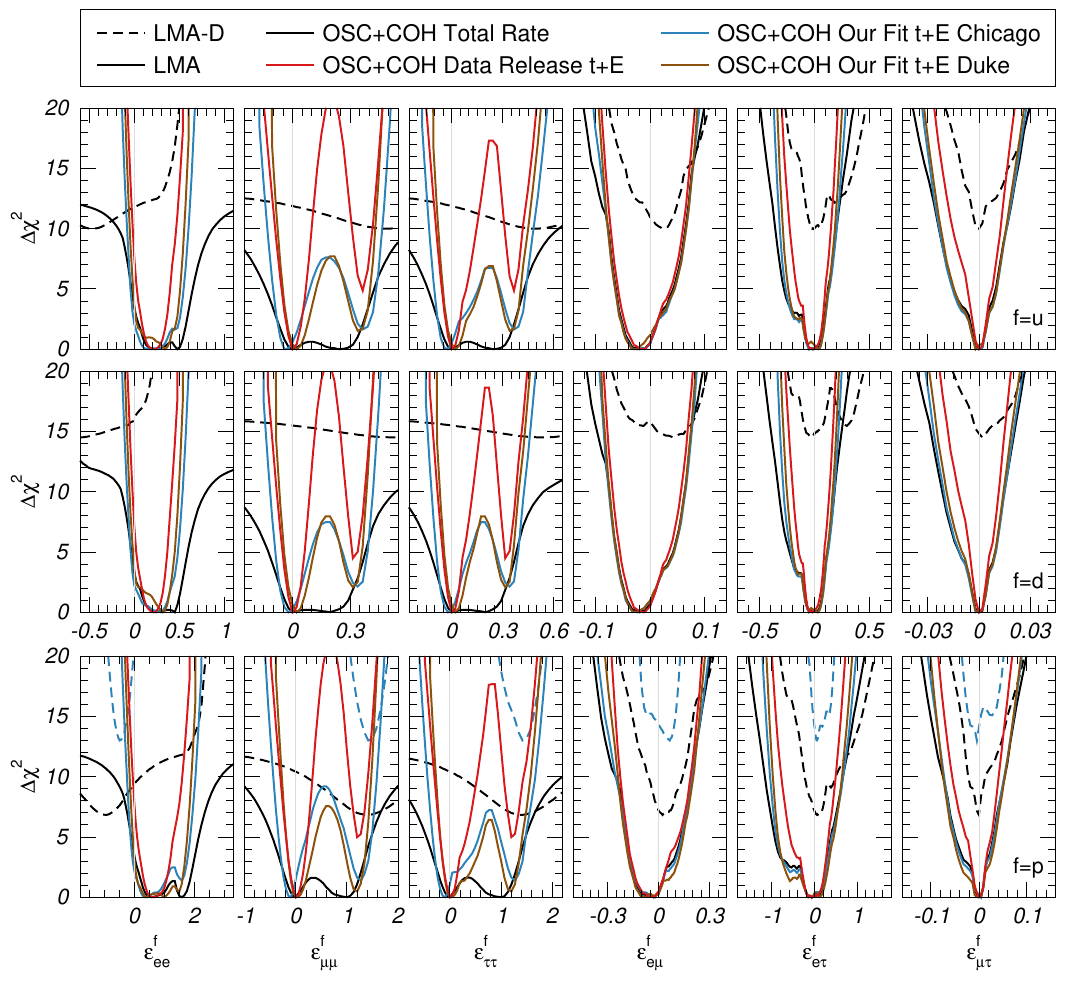
Figure 9 . Dependence of the (cid:1) (cid:31) 2 function on the NSI couplings with up quarks (upper global row), down quark (central row) and, protons (lower row) for the global analysis of oscillation and COHERENT data. In each panel (cid:31) 2 is marginalized with respect to the other (cid:12)ve NSI couplings global not shown and with respect to the oscillation parameters for the LMA (solid) and LMA-D (dashed) solutions. The di(cid:11)erent curves correspond to the di(cid:11)erent variants of the COHERENT analysis implemented in this work: total rate (black), t+E Data Release (red), t+E with QF-C (blue), and t+E with QF-D (brown); see text for